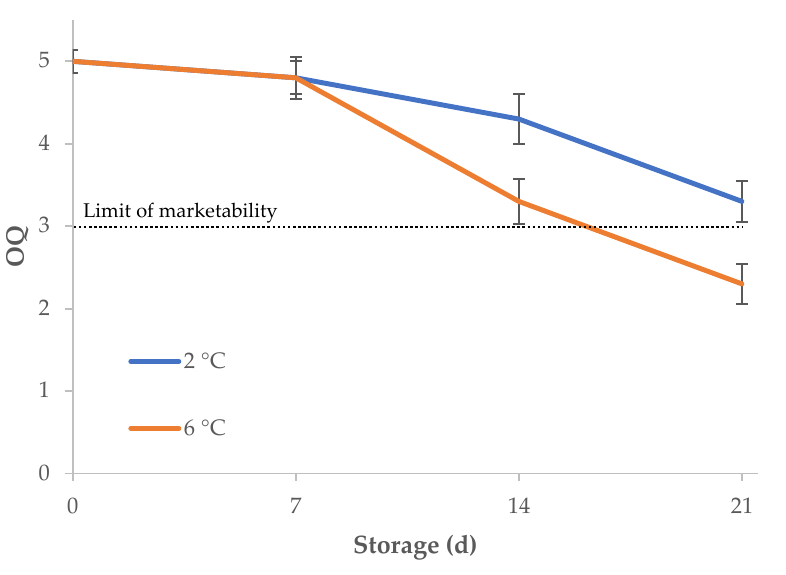
Figure 2. Influence of temperature and time of storage on overall sensory quality (OQ) of minimally processed borage leaves (5: excellent or having a fresh appearance; 3: average-limit of marketability; 1: unmarketable).